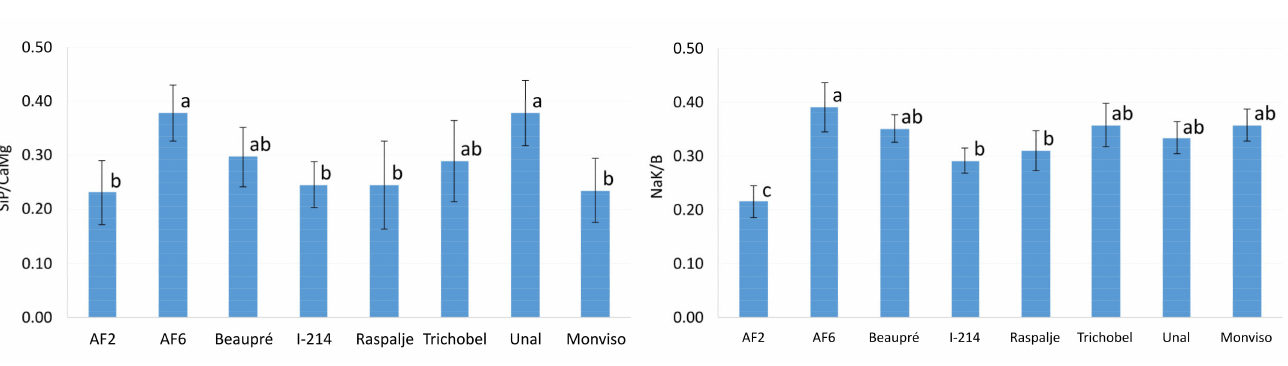
Figure 5. Mean and standard errors of the SiP/CaMg and the NaK/B indices obtained from ash of the eight clones under study. Different letters denote significant differences (Tukey test).